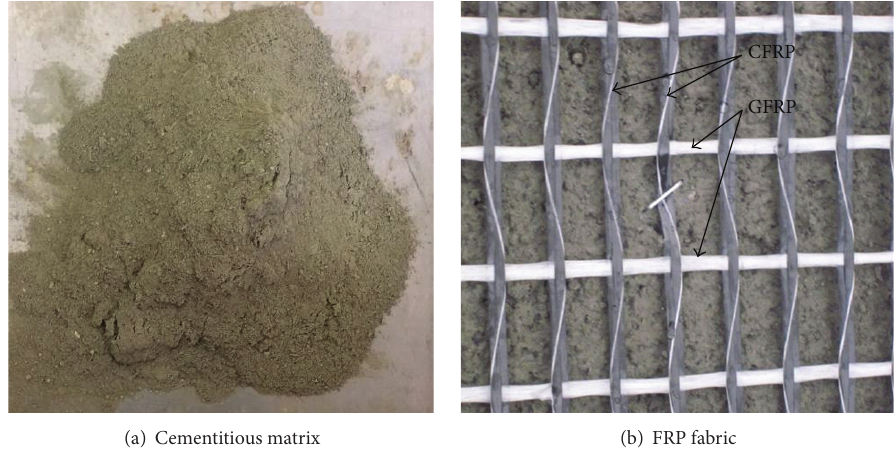
Figure 2: Components of FRCM composite.